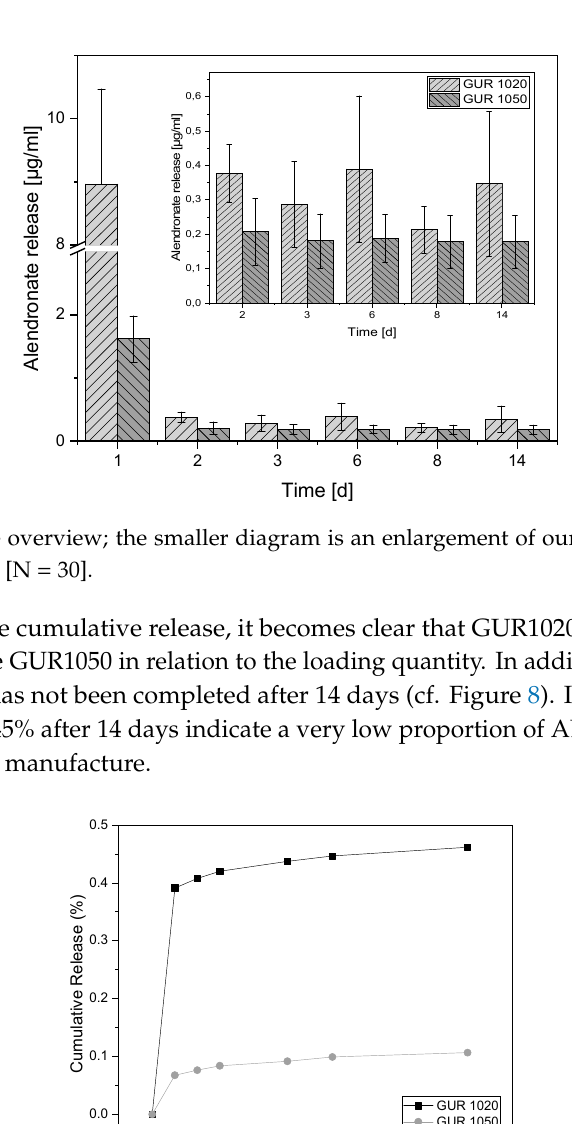
Table 6. Overview of GUR specimen cell counts [N=10].